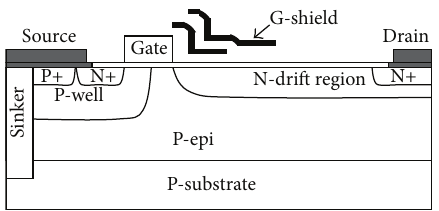
Figure 1: Diagram of the 50 V RFLDMOS